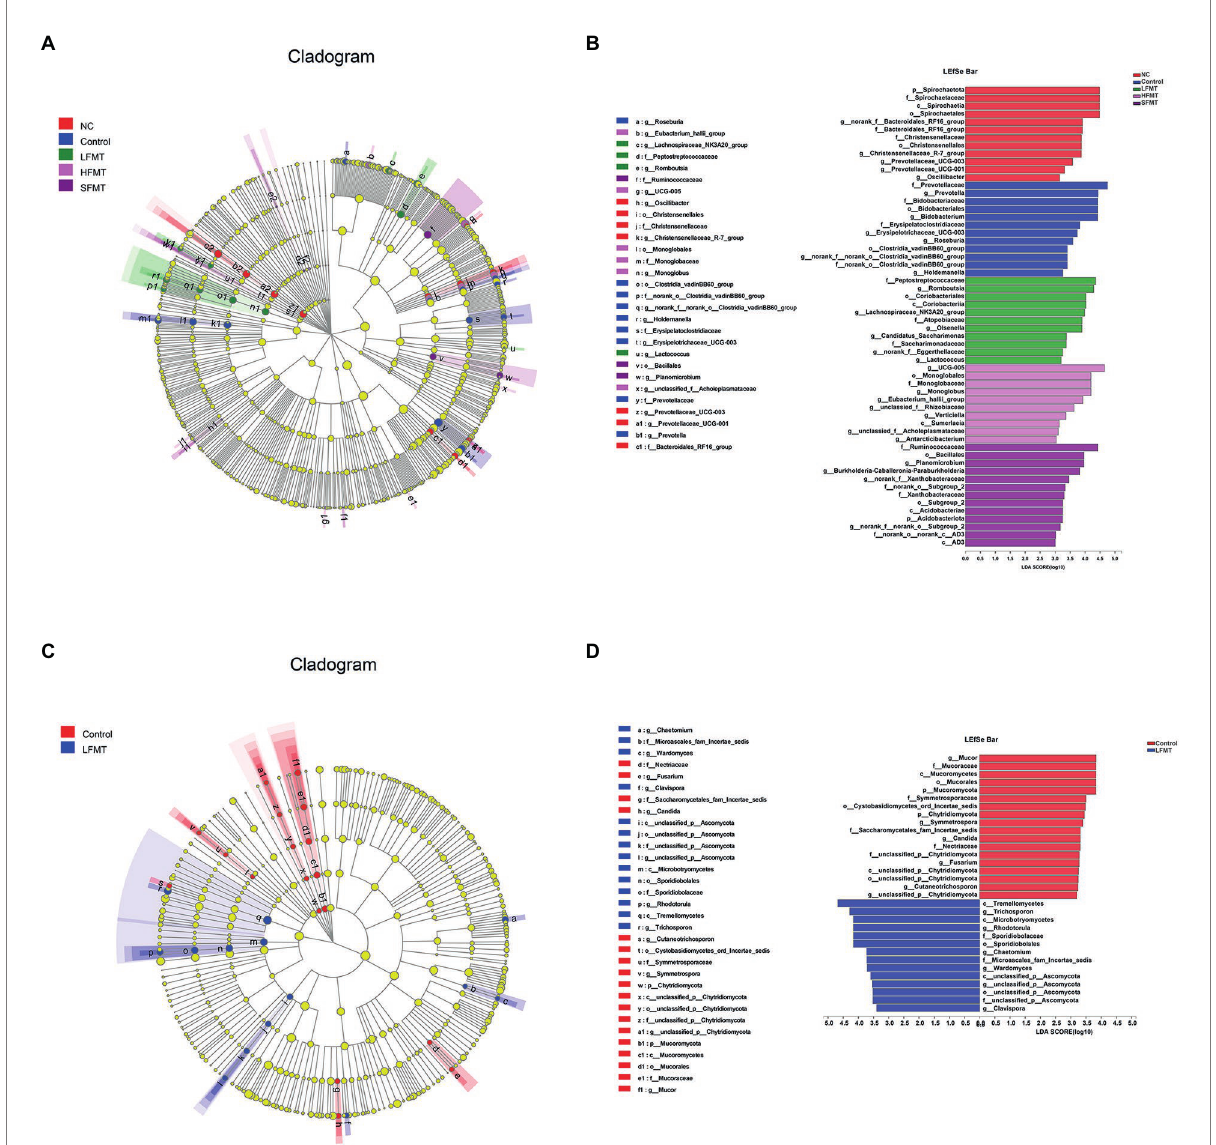
FIGURE 6 LEfSe analysis comparing the differential microbiota among groups. Clade diagram showing the phylogenetic distribution of microbial lineages across different FMT groups. Differences in abundance between groups were assessed using LDA scores. (A) Phylogenetic distribution of bacterial microbiota associated with FMT group and untreated group taxa. (B) LDA > 3 differential bacteria in bacterial communities associated with FMT and untreated groups. (C) Phylogenetic distribution of fungal microbiota associated with FMT group and untreated group taxa. (D) Differential fungi with LDA > 3 in the fungal community associated with the FMT group and the untreated group. The colored circles from the inside to the outside of the LEfSe analysis cladogram represent different taxonomic levels (phylum, class, order, family, genus). The diameter of each circle is proportional to the abundance of the population. The yellow circles in the cladogram represent taxa that are not significantly different. LDA scores > 3 were considered statistically significant. Different colored areas represent different